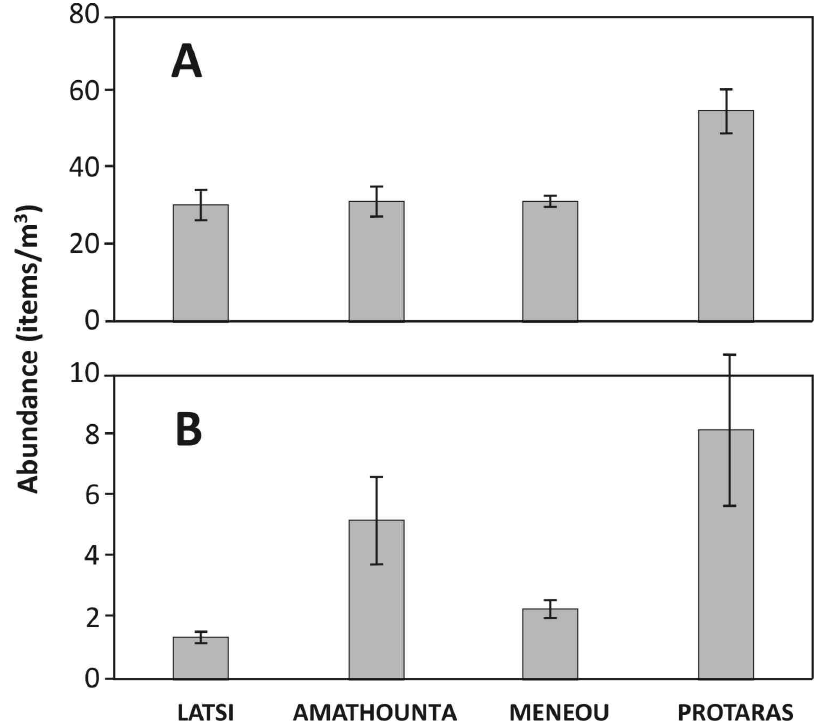
Figure 3. The average abundance (items/m 3 ) ± Standard Error of the microplastic fibers ( A ) and fragments ( B ) recovered from the samples taken in the four sampling areas (Latsi, Amathounta, Meneou and Protaras) during 2017–2019.